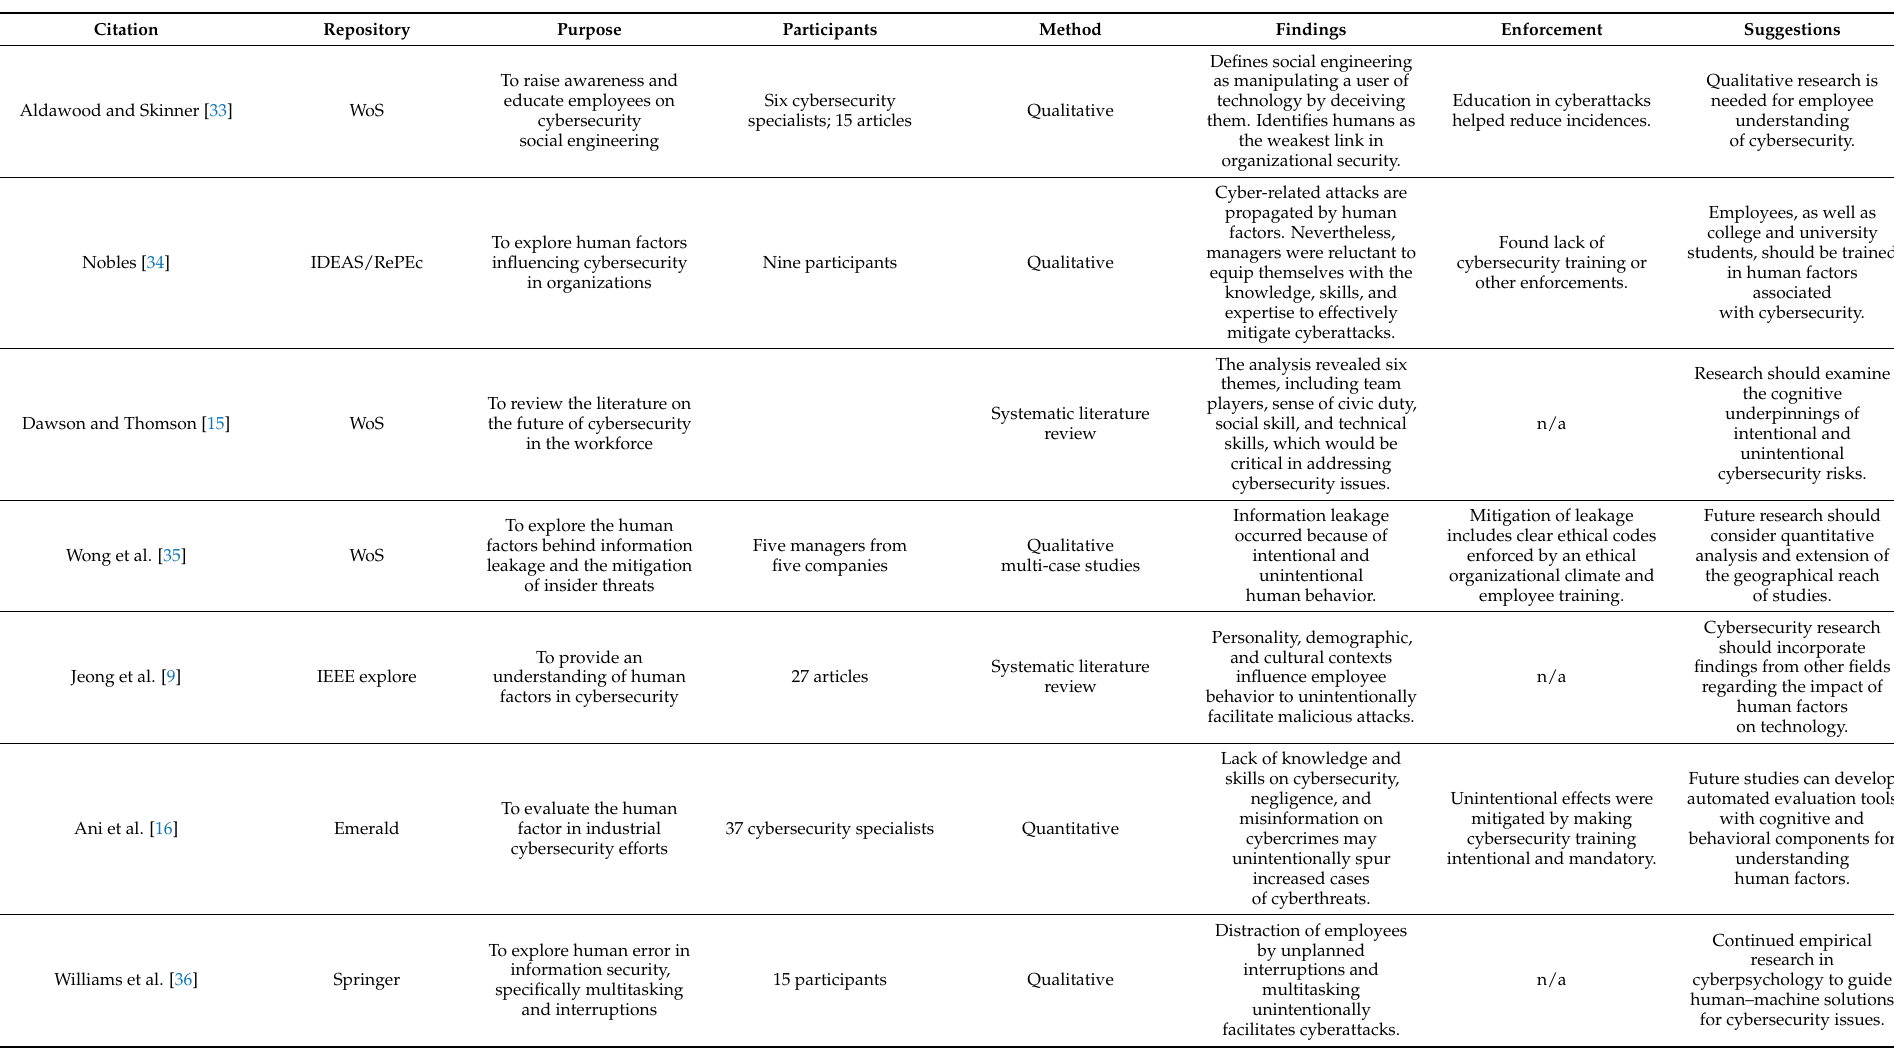
Table 1. Included